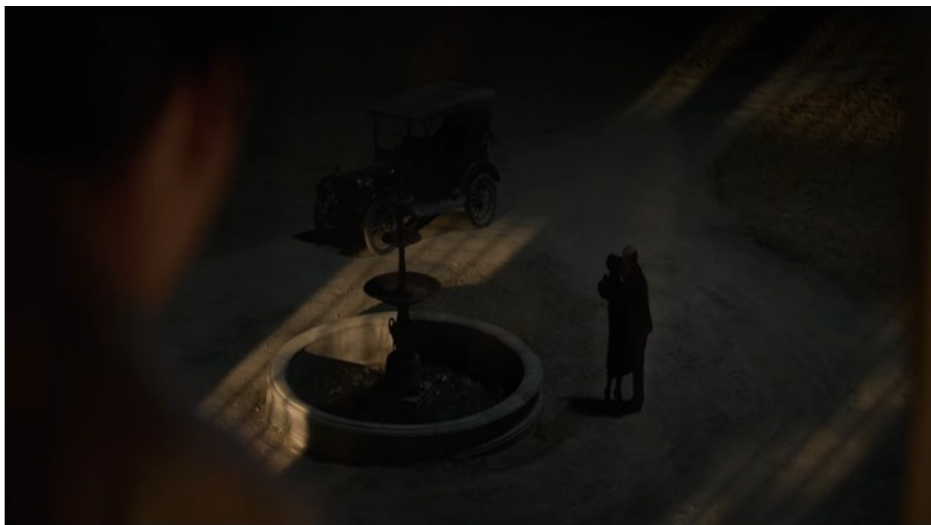
Figure 20. The Power of the Dog . Netflix.